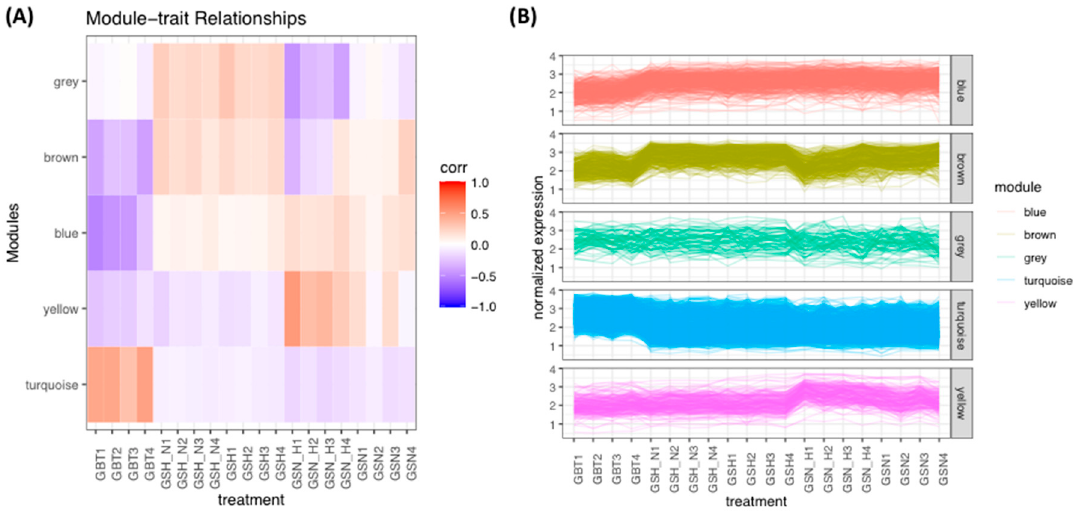
Figure 4. ( A ) The correlation heatmap by module eigengenes and the treatments in DEGs of the GSE45117. ( B ) The plot of normalized expression values of DEGs and the modules related to the treatments of the GBM dataset. Table 2. The GO and KEGG pathway enrichments of the 61 common hub genes in the turquoise